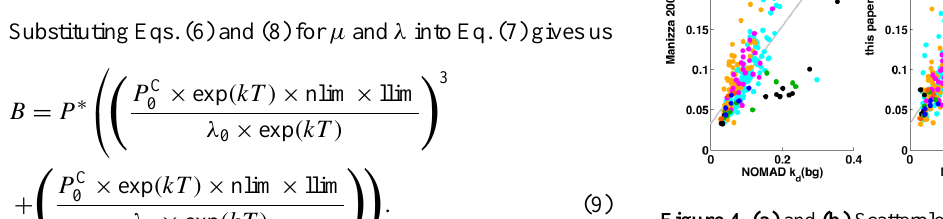
Figure 4. (a) and (b) Scatterplots comparing observed k d ( bg ) from the NOMAD data set and modeled k d ( bg ) using two different pa- rameterizations, Eqs. (3) and (5). The modeled k d ( bg ) values are calculated from in situ chlorophyll a and a dg ( 443 ) measurements corresponding to the observed k d ( bg ) values on the x axis. (c) Com- parison of Eqs. (3) and (5) applied to NOMAD in situ chlorophyll concentrations and a dg ( 443 ) measurements to calculate k d ( bg ) . The 0.88 slope on the regression line indicates that when CDM is in- cluded, k d ( bg ) increases more rapidly than when it depends on chlorophyll concentration alone. Color coding corresponds to re- gional groupings from Fig.